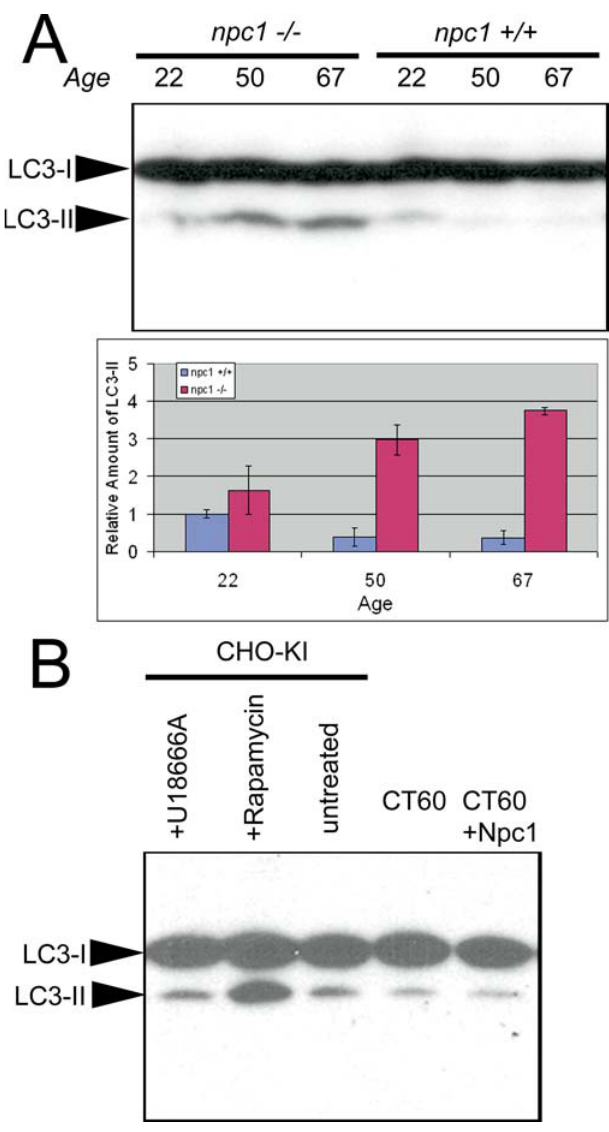
Figure 7. Levels of the Autophagosomal Marker LC3-II Are Increased in Degenerating npc1 Cerebellum (A) Immunoblots of 70 l g of protein resolved by 15% SDS-PAGE show increased levels of LC3-II in 50- and 67-d-old npc1 cerebellar extracts. Two mice of each age and genotype were analyzed, and relative band intensities were quantified. p- Values derived from comparing wild-type and npc1 (cid:1) / (cid:1) cerebella at each age are 0.3, 0.01, and 0.001 for 22-, 50-, and 67-d-old mice, respectively. (B) Immunoblots of CHO cell extracts resolved by 15% SDS-PAGE do not show increased levels of LC3-II in CT60 cells compared to wild-type CHO- KI cells or CT60 cells stably transfected with NPC1-YFP. No difference is noted with 10 l M U18666A, a drug that mimics npc1 loss of function. Rapamycin treatment (1 l M) of CHO-KI cells demonstrates robust activation of autophagy with increased LC3-II